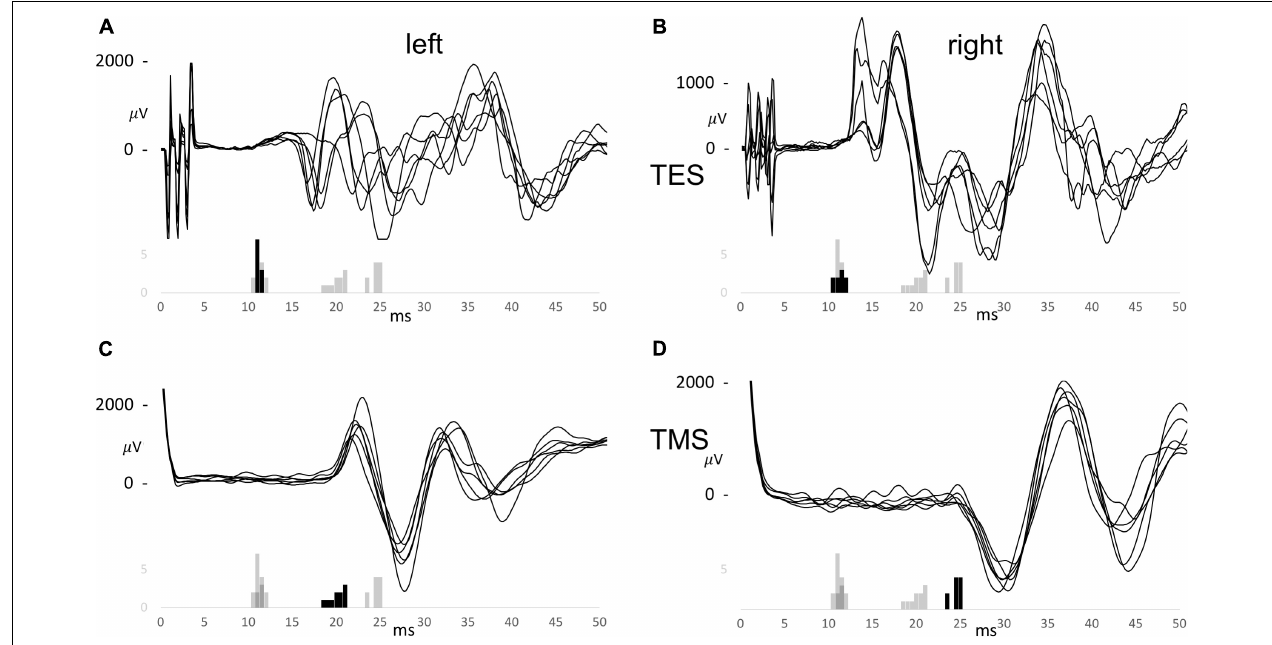
FIGURE 2 | Trapezius motor evoked potential (MEP) series for TES (A,B) and TMS (C,D) for the left (A,C) and the right (B,D) sides of the first combined TES/ TMS case. The histograms are overlaid and summarize the EL and ML latency times for TES between 10 and 50 V and for TMS between 10 and 50%. The black bars belong to the specific group of which 6 curves are shown. The MEP curves share the time scale of the histograms.